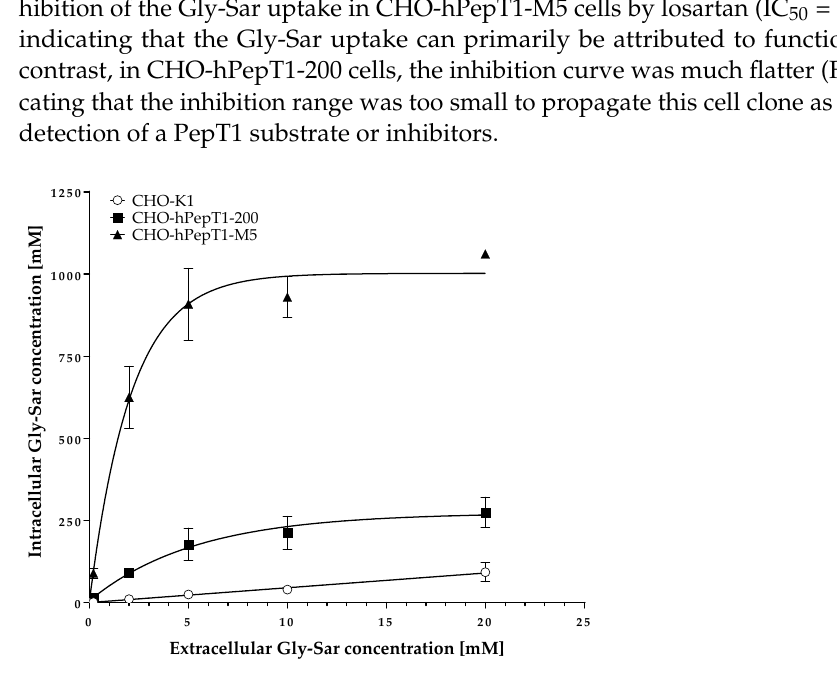
Figure 3. Uptake of Gly-Sar in CHO-K1, CHO-hPepT1-200, and CHO-hPepT1-M5 clones. The data points represent the mean ± S.E.M. of three independent experiments with each concentration tested in triplets.